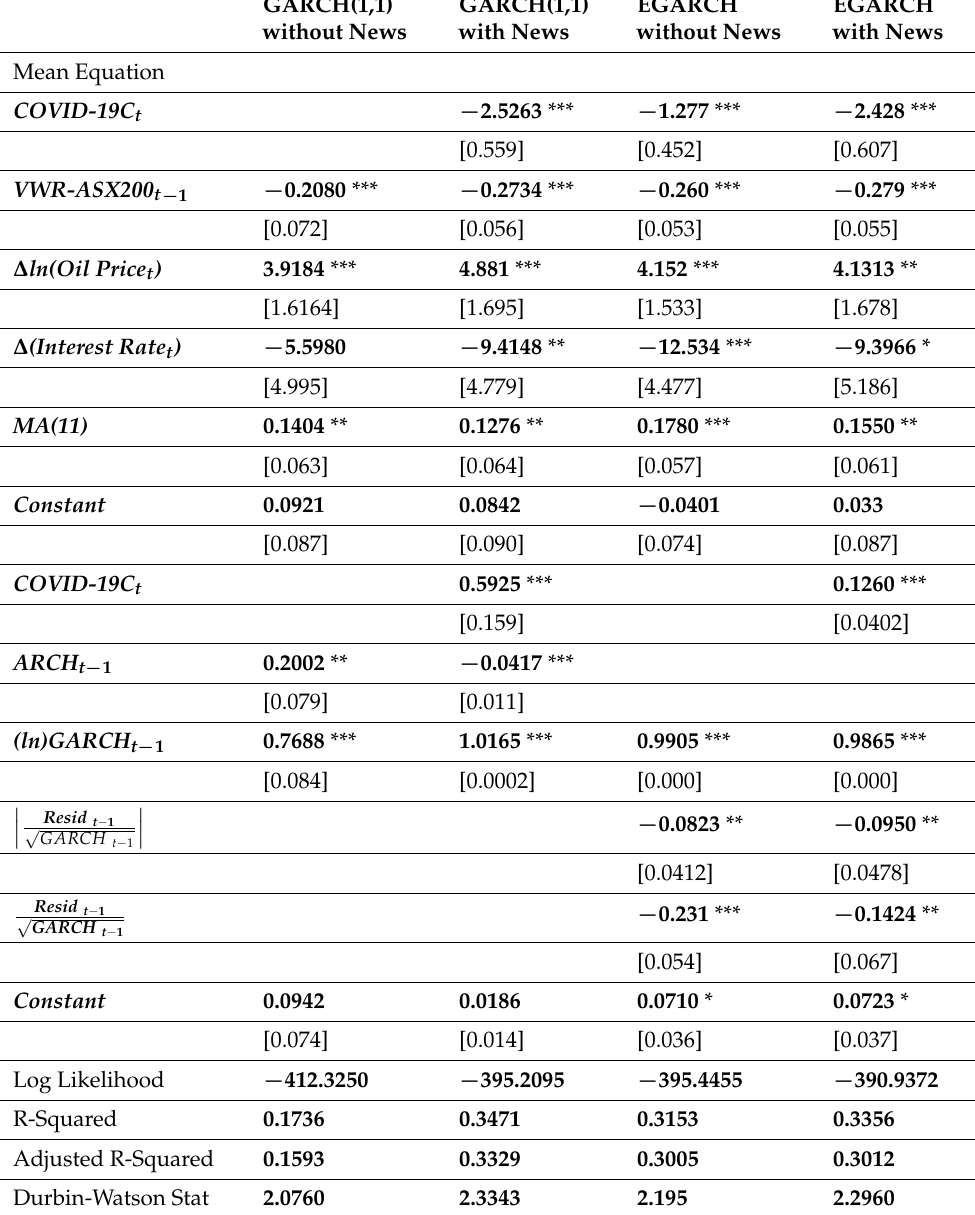
Table 5. This table shows GARCHX estimates to show the effect of COVID-19 on the VWR of ASX200 and their volatility. We use data of 197 stocks listed on S&P/ASX200 from 27 January 2020 to 30 December 2020 to examine the effect of COVID-19 on Australian stock returns and their volatility. VWR-ASX200 is the value-weighted return of 197 stocks listed in S&P/ASX200 at level, Oil Price is the international crude oil price to the order I(1), the Interest rate is Australian one-month interbank interest rate to the order I(1), COVID-19A represents the total number of confirmed cases in Australia due to COVID-19 to the order I(1), COVID-19B represents the total number of deaths in Australia due to COVID-19 to the order I(1) and COVID-19C is a dummy variable depicting the negative news, and it takes a value of 1 from 24 February 2020 to 22 March 2020 otherwise 0.